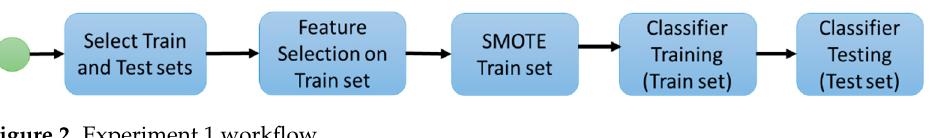
Figure 2. Experiment 1 workflow.